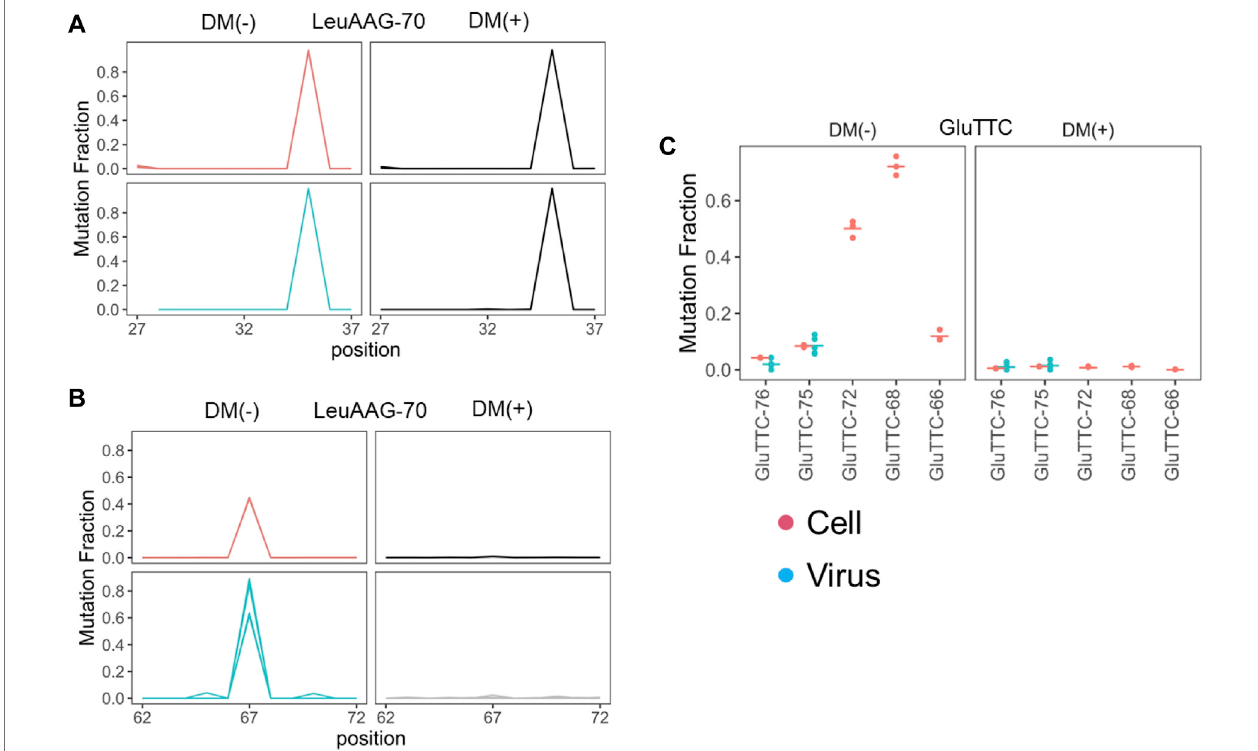
FIGURE4| SelectiveenrichmentoftRNAwithm 1 Amodi fi cationpro fi les.MutationfractionsfromuninfectedVerocell( n =3,red)orcellfreeviralpreparations( n =6, blue) are shown. (A) Mutation fractions of tRNA Leu (AAG) residues around the wobble anticodon position (35 for this tRNA) without (DM-) and with (DM+) demethylase treatment showing the I34 modi fi cation. (B) Mutation fractions of tRNA Leu (AAG) around the residues at position 67 which corresponds to m 1 A58 in the tRNA nomenclature. tRNA Leu (AAG) shows higher mutation fraction in the viral preparations, consistent with SARS-CoV-2 selectively packaging m 1 A modi fi ed tRNA Leu (AAG). (C) Mutation fractions of the top fi ve abundant tRNA Glu (TTC) isodecoders at position 57 (DM-) which is validated as m 1 A in the T loop upon removal by demethylase treatment (DM+). Isodecoder nomenclature is according to the tRNAScan score of each tRNA Glu (TTC) gene. The two isodecoders enriched in the viral preparations are nearly unmodi fi ed, corresponding to their counterparts in the Vero cells.